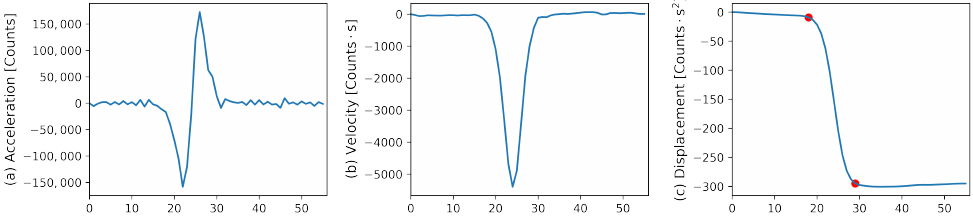
Figure 3. Step table output from one step (step table moving down) with sensor number 0067 ( a ) Direct sensor output (acceleration), ( b ) Integrated sensor output (velocity), ( c ) Twice integrated sensor output (displacement), with manually chosen start and end of step shown by the two red